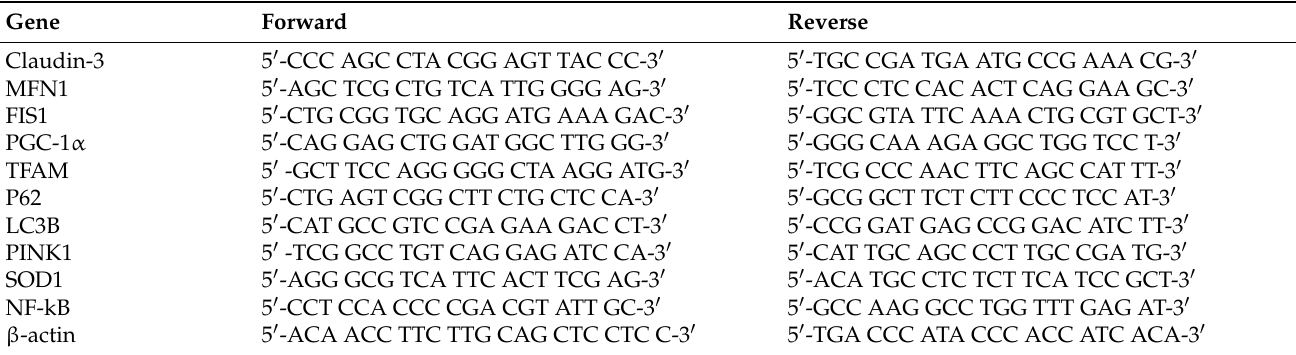
Table 1. List of primers for